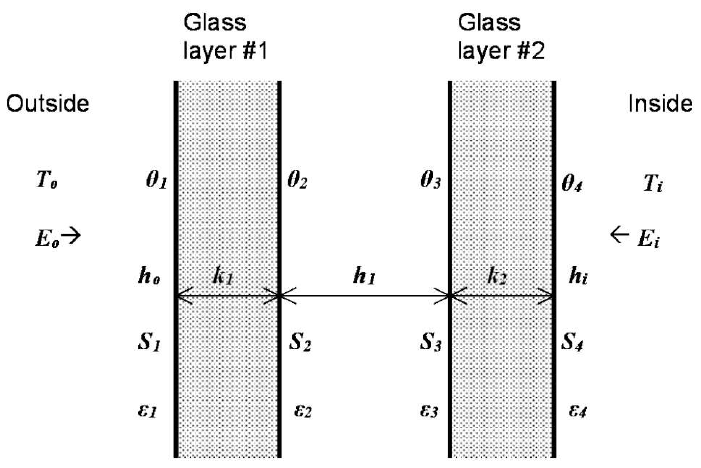
Figure 5. EnergyPlus layer-by-layer energy